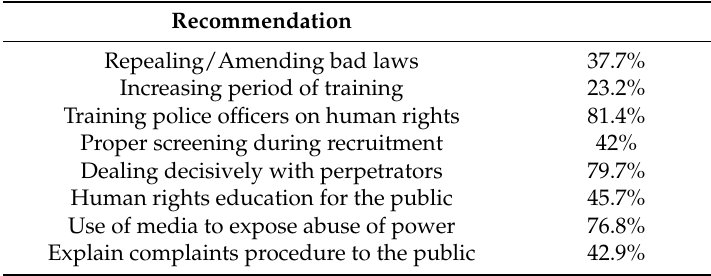
Table 7. The response on ameliorating strategies and recommendations, N =